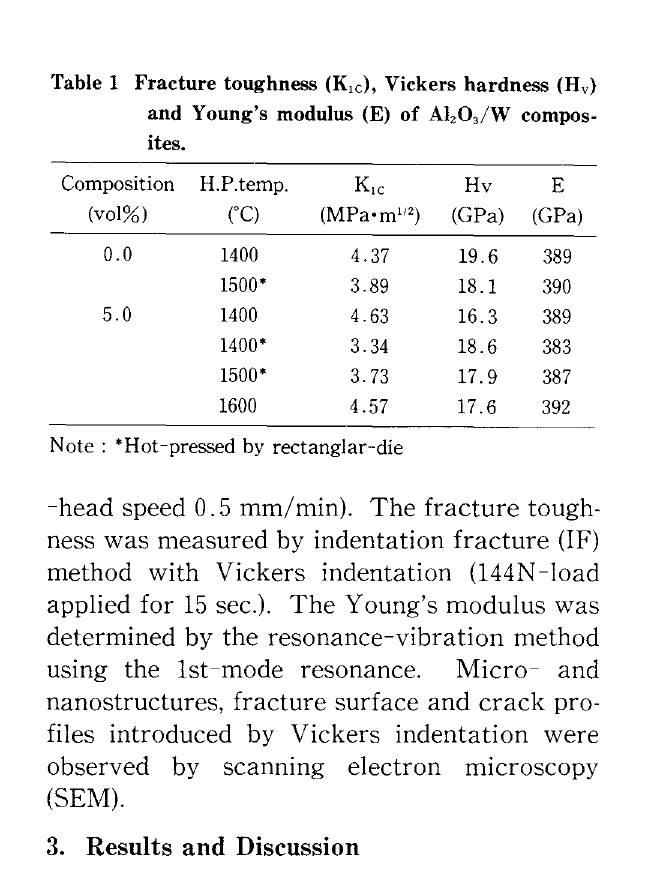
Table 1 Fracture toughness (KIC), Vickers hardness (Hv)